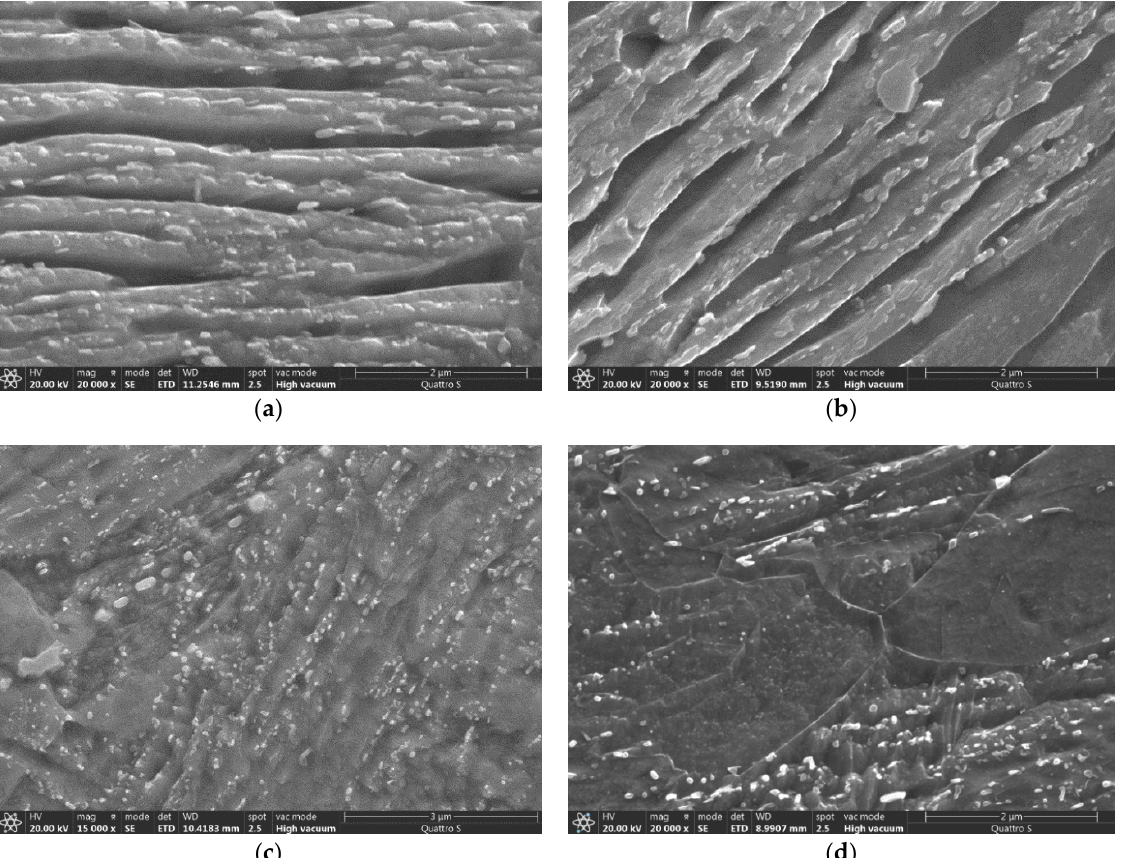
Figure 9. Microstructures of samples annealed at different intercritical temperatures; SEI. ( a ) 740 °C ( b ) 760 °C ( c ) 780 °C ( d ) 800 °C.